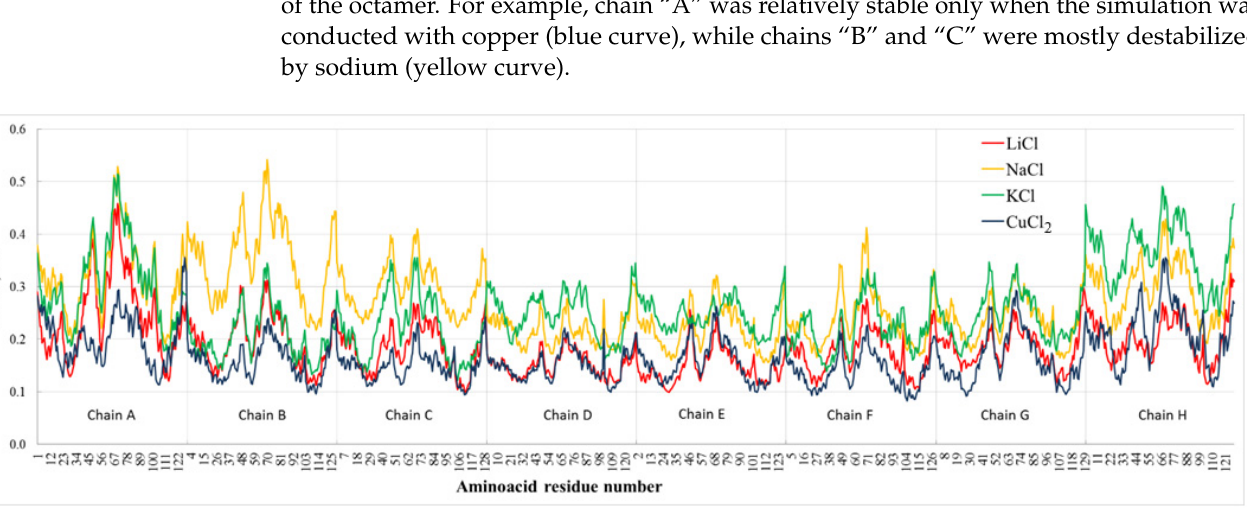
Figure 2. RMSF of octamers with different precipitants: LiCl, NaCl, KCl and CuCl 2 . Chains A–H are the polypeptide chains of octamers.